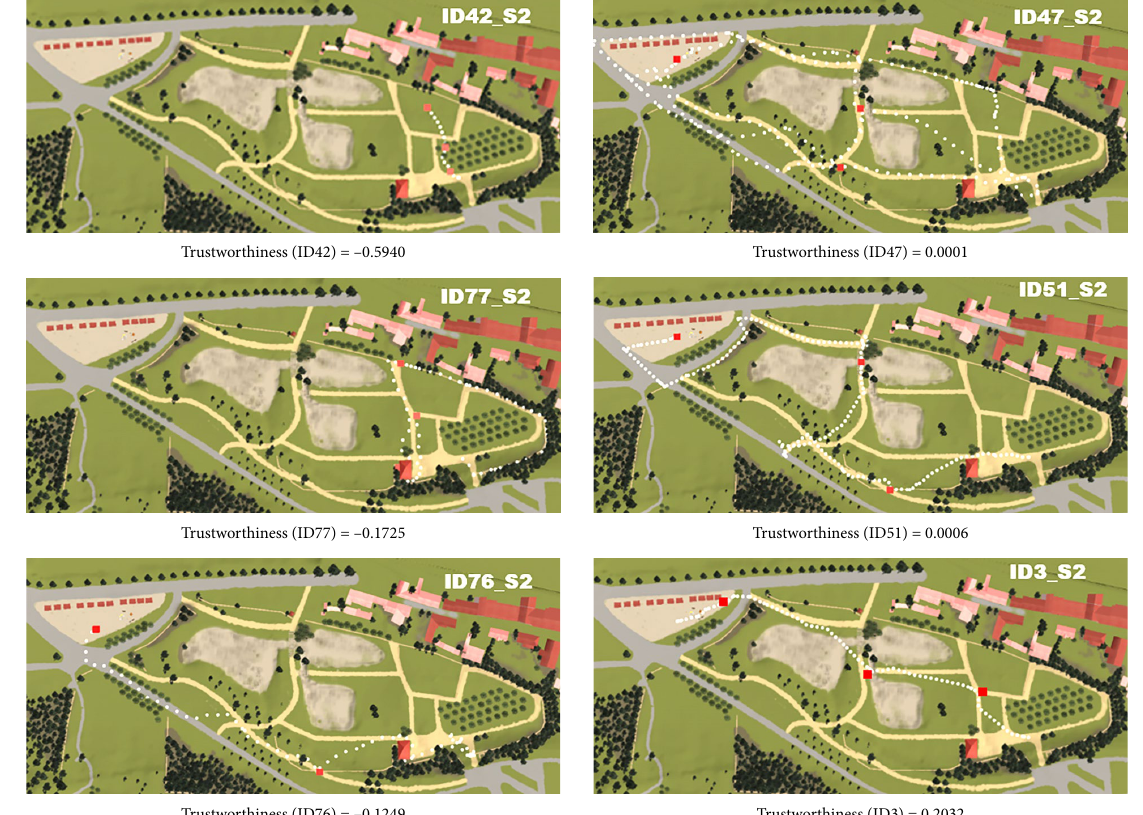
Figure 7. The behaviour of the selected respondents that played Scenario 2 in the game-based survey PARKIS